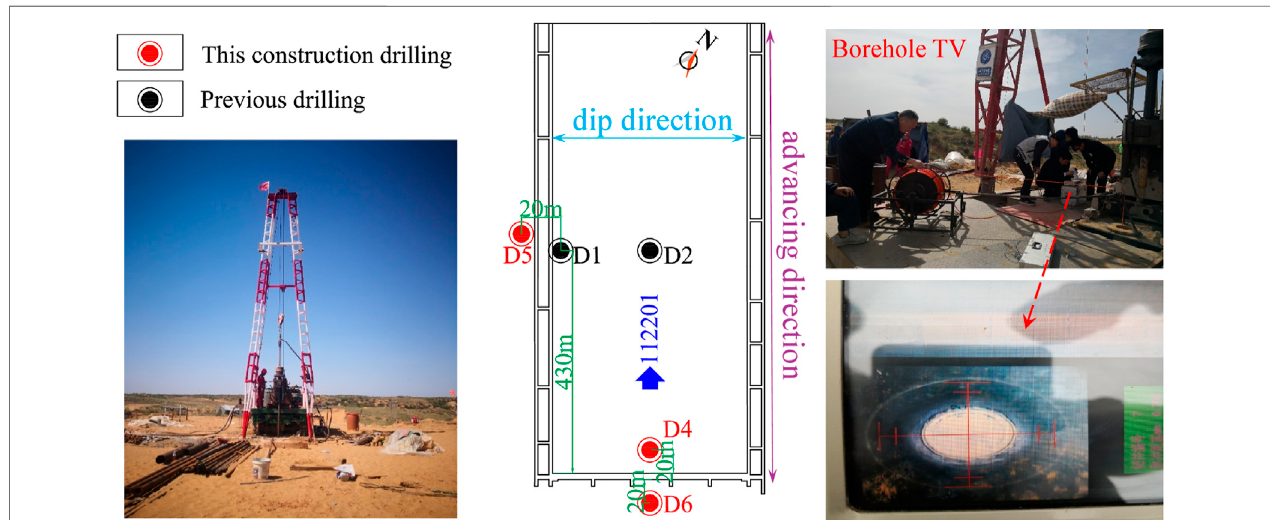
FIGURE 4 | Drilling